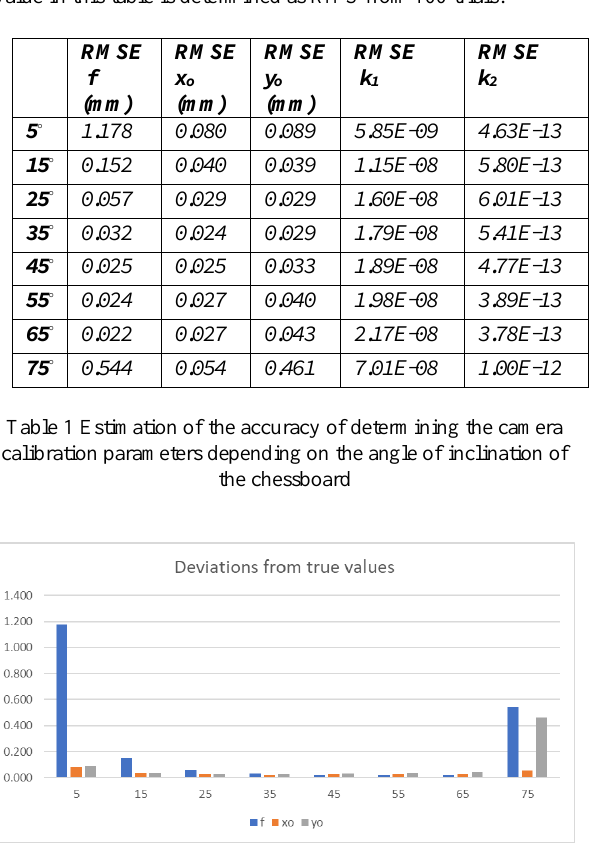
Figure 2. Evaluation of the accuracy of determining the camera calibration parameters depending on the angle of the chessboard The results of experimental studies on synthetic data have shown that this calibration method has the right to exist. It is easily implemented, and gives positive results. To achieve the maximum result in camera calibration accuracy using this method the tilt the chessboards should be in the range of 30-40 degrees to the optical axis of the camera being calibrated.